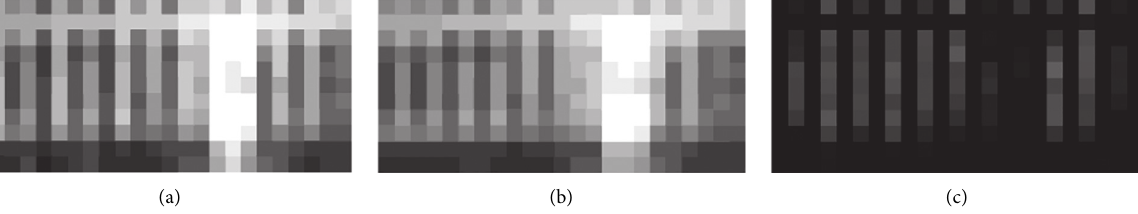
Figure 5: (a) Image patch of intercell busbar with heterogeneous background and a short circuit. (b) The estimated background. (c) Result of background removal. There is an opening among normal working suspenders.